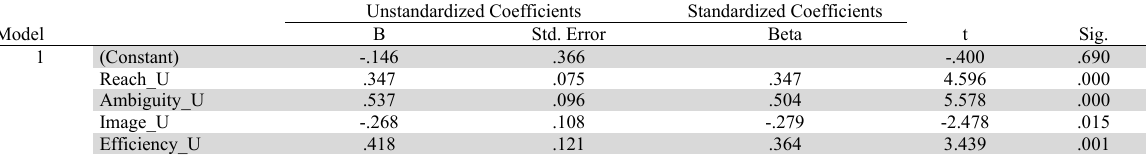
The results of testing the first hypothesis